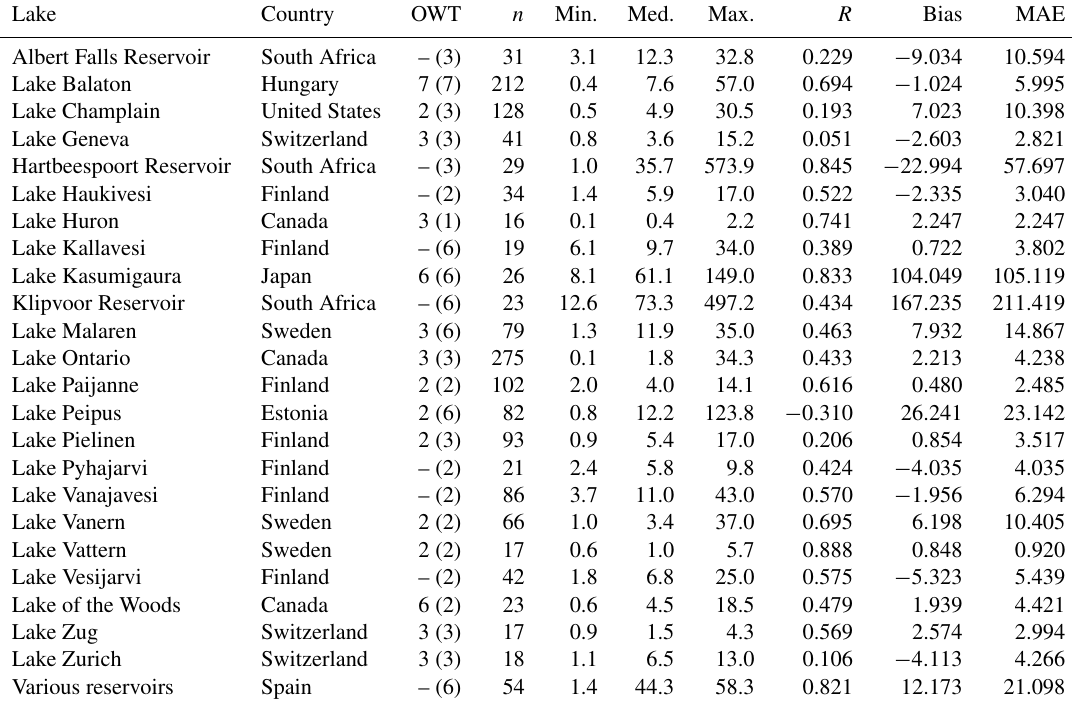
Table 2. Statistical metrics and ancillary information for chl- a matchup data and the MPH algorithm. n/Min./Med./Max. describe the in situ measurement counts and ranges represented by the matchups. OWT are indicated as the mode of the 9-year averaged products where available, as well as for the available matchup data for MPH (in